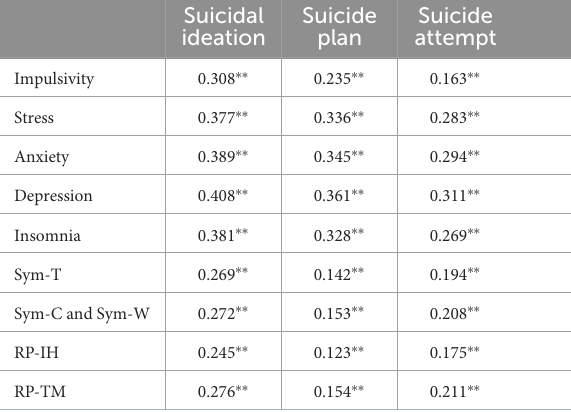
TABLE 4 Correlations between IA, impulsivity, stress, anxiety, depression, insomnia and SB. Suicidal Suicide ideation